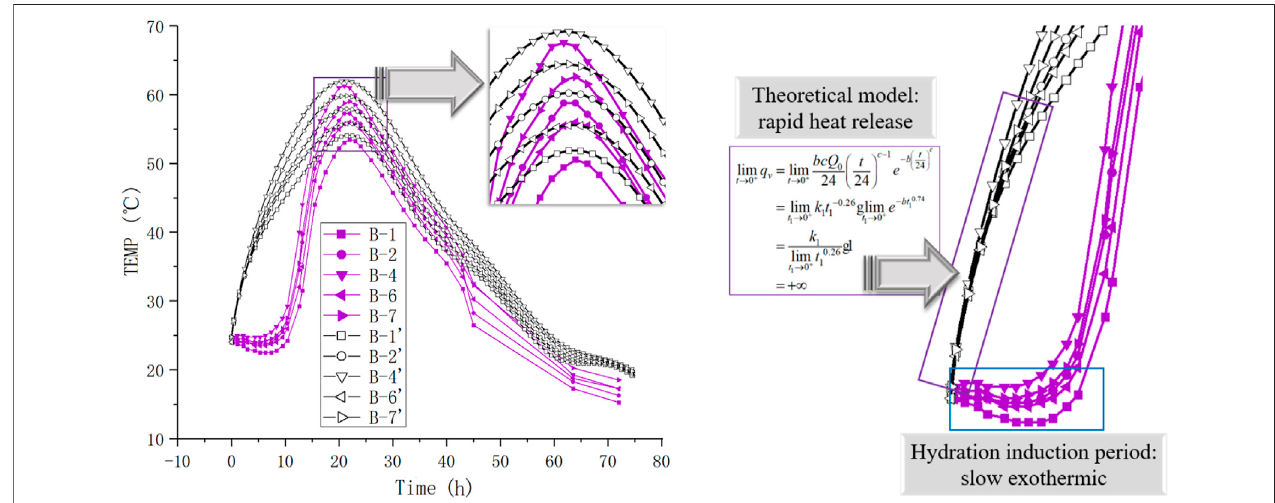
FIGURE 11 | Comparison of measured point temperatures in surface test